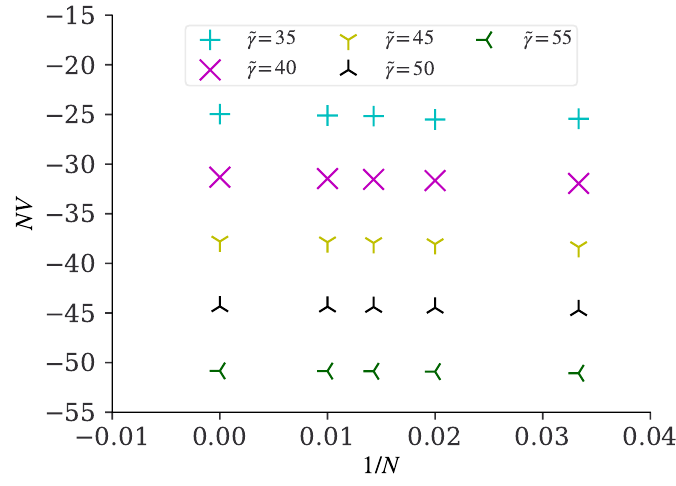
Figure 7. Our θ = 0 numerical results for N times the tree energy V versus 1 /N for N = 30 , 50 , 70 , 100 , ∞ , or equivalently 1 /N = 0 . 0333 . . . , 0 . 02 , 0 . 0142 . . . , 0 . 01 , 0 , for several values of ˜ γ . These results suggest that the N → ∞ limit of V is smooth at each fixed ˜ γ